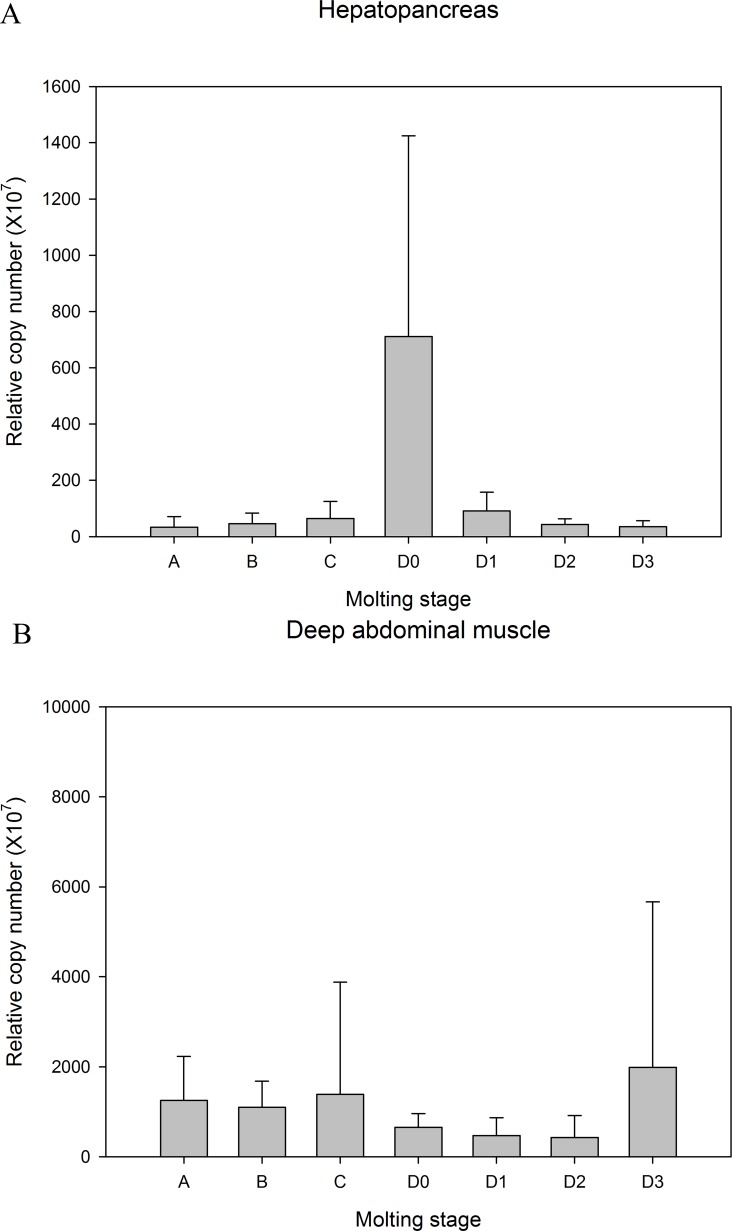
Relative copy number of Liv-AdipoR in (A) hepatopancreas and (B) deep abdominal muscle in different molt cycle.Copy numbers were normalized by the number of 18S rRNA. Stage A (early post molt), Stage B (late postmolt), Stage C (intermolt), Stage D0 (onset of premolt), Stage D1 (early premolt) Stage D2 (intermediate premolt), Stage D3 (late premolt).